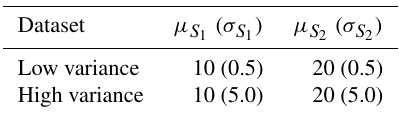
Table 3. Mean and variance of the two sources, S 1 and S 2 , drawn from normal distributions.